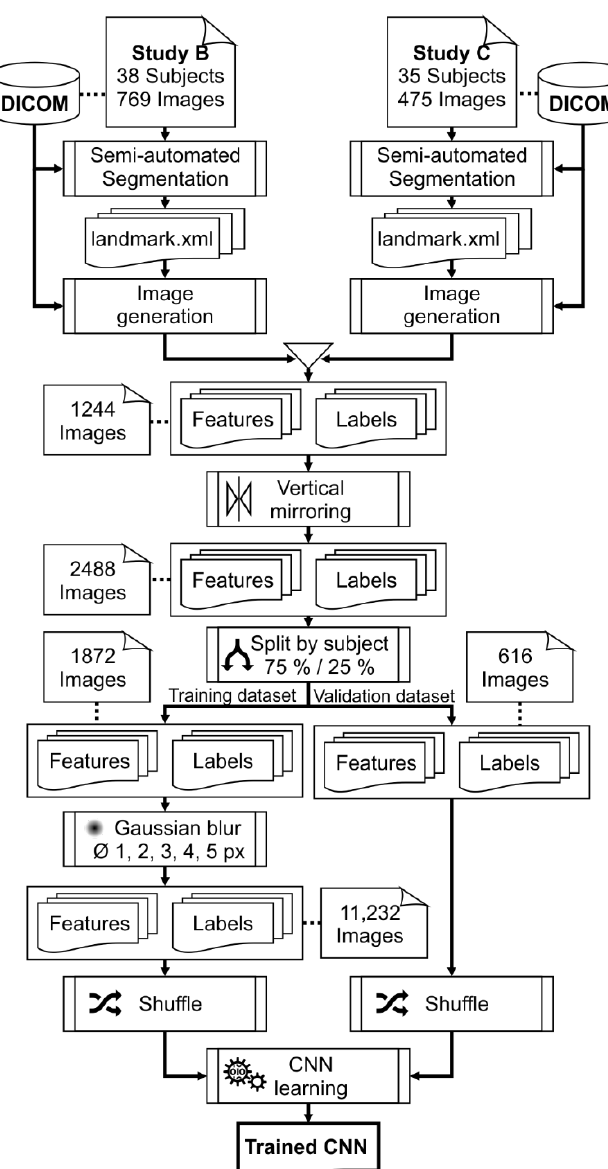
Figure 2. Workflow of the preparation of training and validation data. DICOM files are converted to feature and label (Ground truth) images using previously created segmentation files. All images are mirrored vertically, and the training data are additionally augmented using Gaussian blur of five different radii.